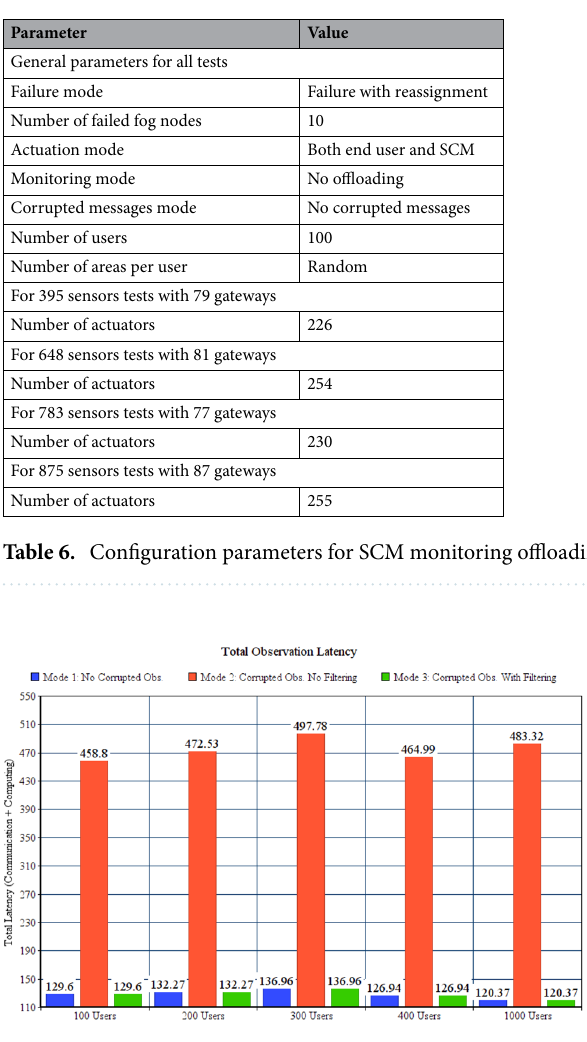
Figure 8. Actuation computing latency for SCM monitoring offloading